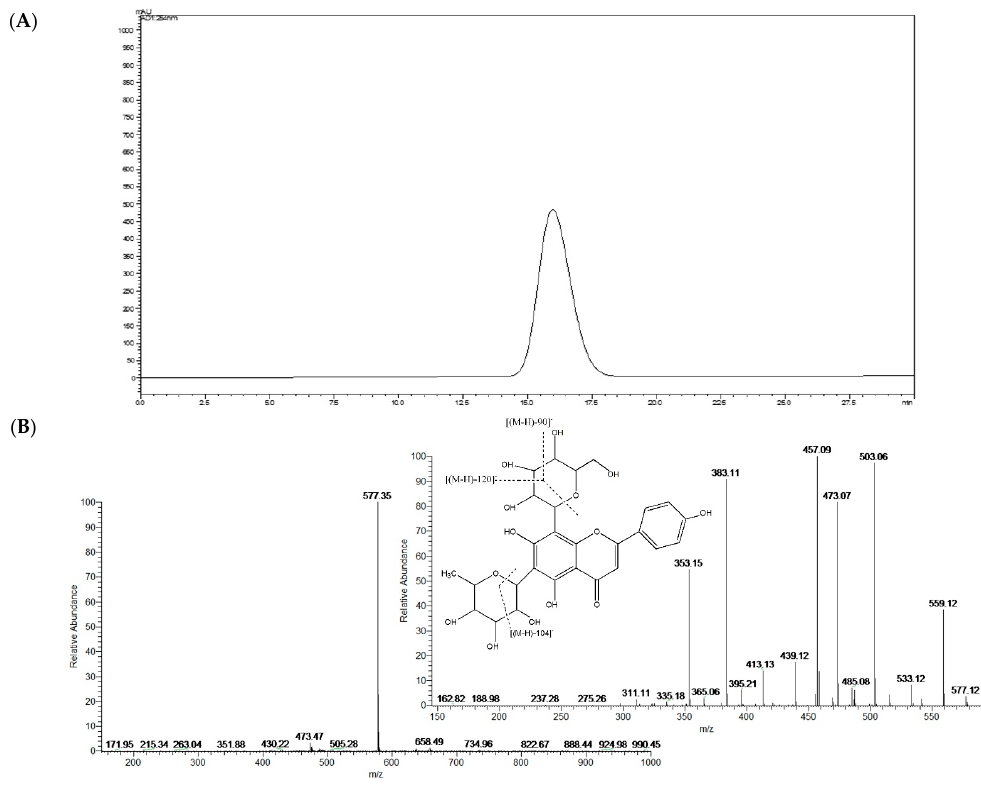
Figure 1. Structural identification of isoviolanthin. ( A ) The HPLC chromatographic analysis and ( B ) MS and MS 2 spectra of isoviolanthin.